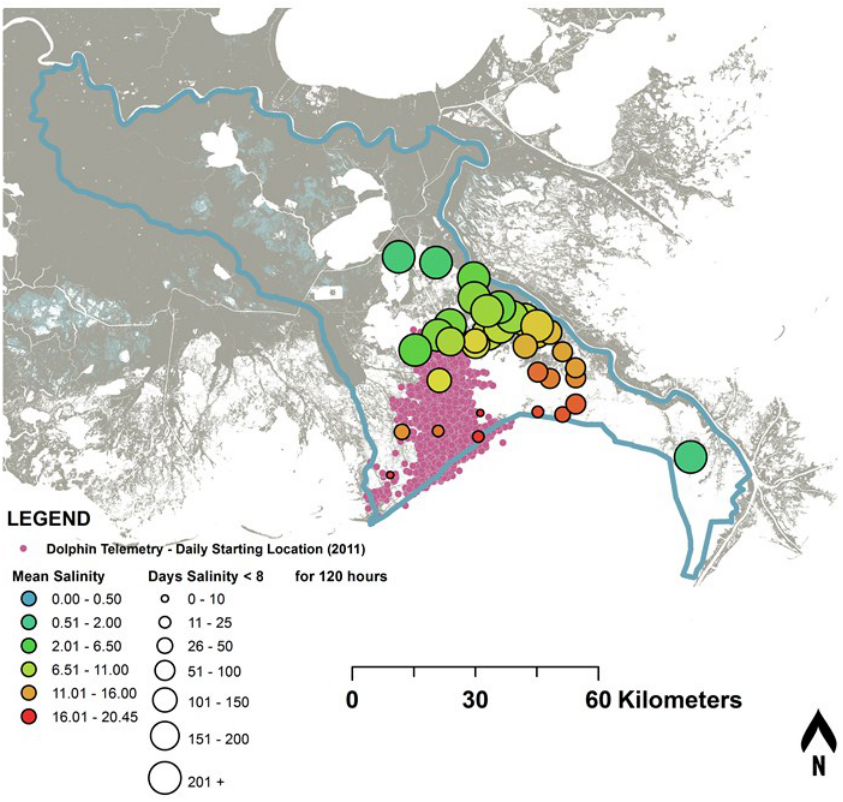
Figure 7. Annual mean salinity (ng/kg) (dot color) and number of days in which the mean salinity was less than 8 ng/kg for at least 120 consecutive hours (dot size) for 2011, overlaid with daily dolphin telemetry locations (purple dots) in 2011.